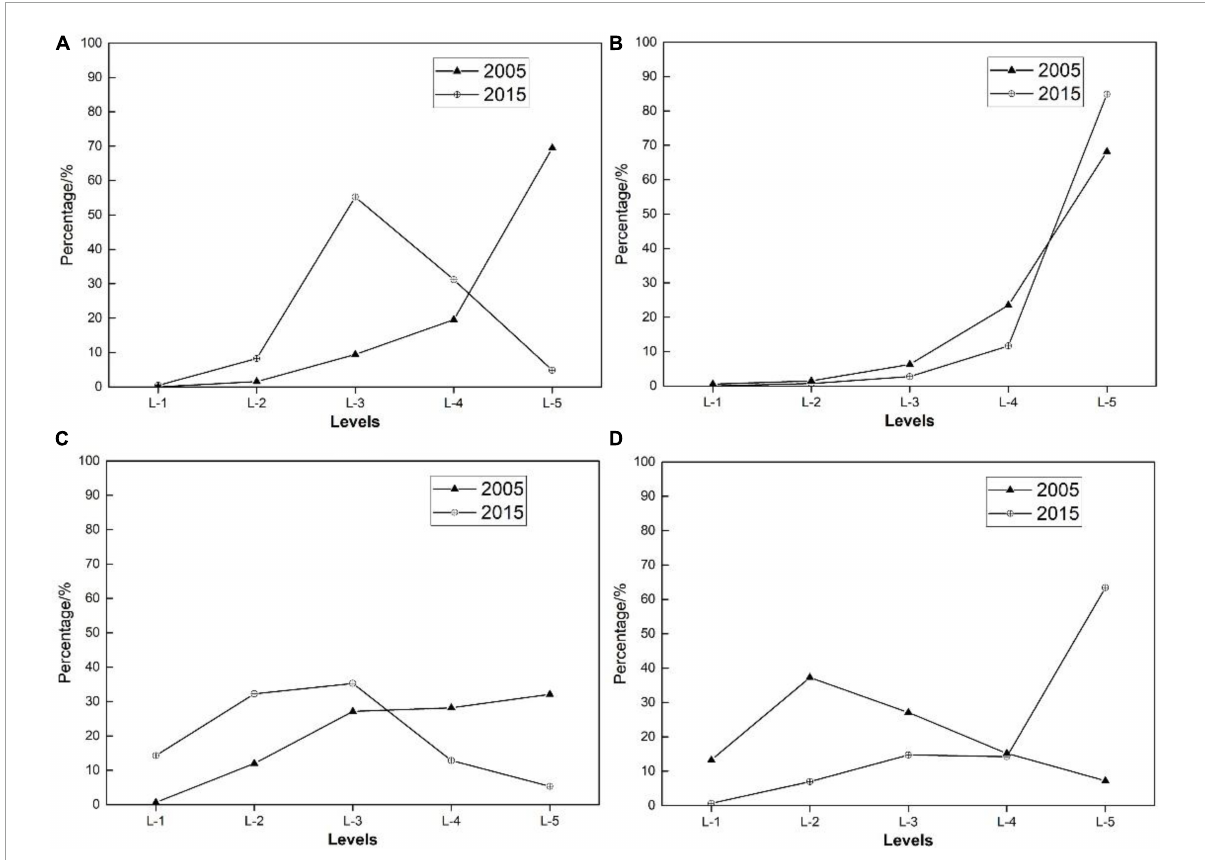
FIGURE5 The percentage of wetland at the annual-variation level, in the changed terrestrial region. Panels (A,B) are an ecological fluctuation grade of the Shuangtai River Estuary. Panels (C,D) are in the Yellow River Delta. Additionally, Panels (A,C) are the significant analysis results of wetland ecology in the degradation (negatively change) area. Compared to 2005, the ecological status of the study area showed a trend of significant improvement in 2015; meanwhile, Panel (D) is the significant analysis results in the improvement (positively change) area; in particular, Panel (B) is always a relatively stable ecological improvement area between 2005 and 2015. The X -axis is the annual change grades, including L-1, -2, -3, -4, and -5, corresponding to the highly insignificant level, insignificant level, normal level, significant level, and extremely significant level. The Y -axis is the percentage (%) of the changing area with a certain variation level.